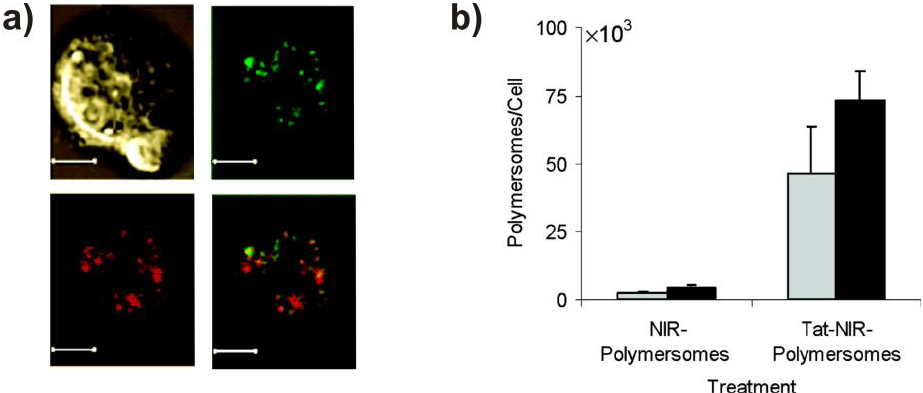
Figure 9. PBD- b -PEG polymersomes, surface-functionalized with the cell penetrating peptide Tat and carrying near infrared fluorophores, were used to label immature dendritic cells. ( a ) Confocal laser scanning microscopy image (transmission, FITC-Tat fluorescence (green), near-infra red (NIR) fluorescence (red), and overlay of fluorescence channels). ( b ) Comparison of intracellular uptake between non-functionalized polymersomes and Tat-functionalized polymersomes. Reproduced and adapted by permission of the American Chemical Society